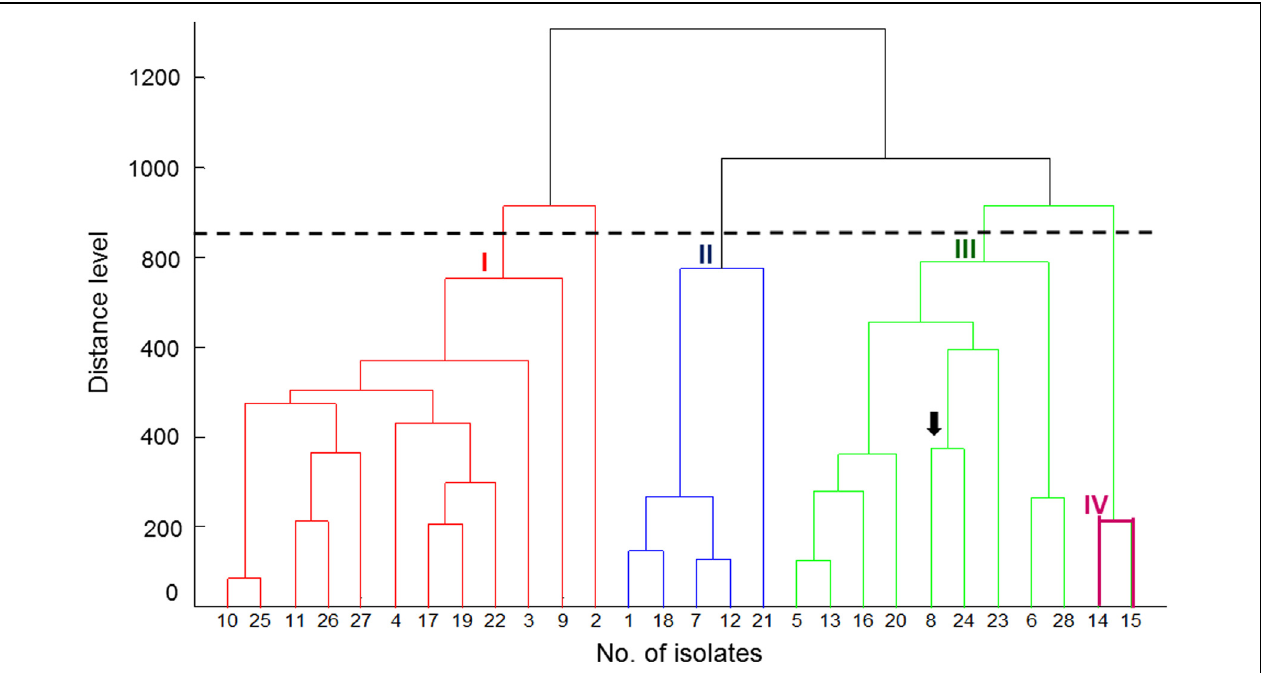
FIGURE 1 | Principal component analysis (PCA) dendrogram generated by MALDI Biotyper mass spectra for 28 genetically well characterized isolates of Penicilliun marneffei . The arrow indicates the NTUH-3370 isolate. The dendrogram obtained from the MALDI Biotyper data of 25 isolates shows four cluster groups (I, II, III, and IV) with a default critical distance level of 850.